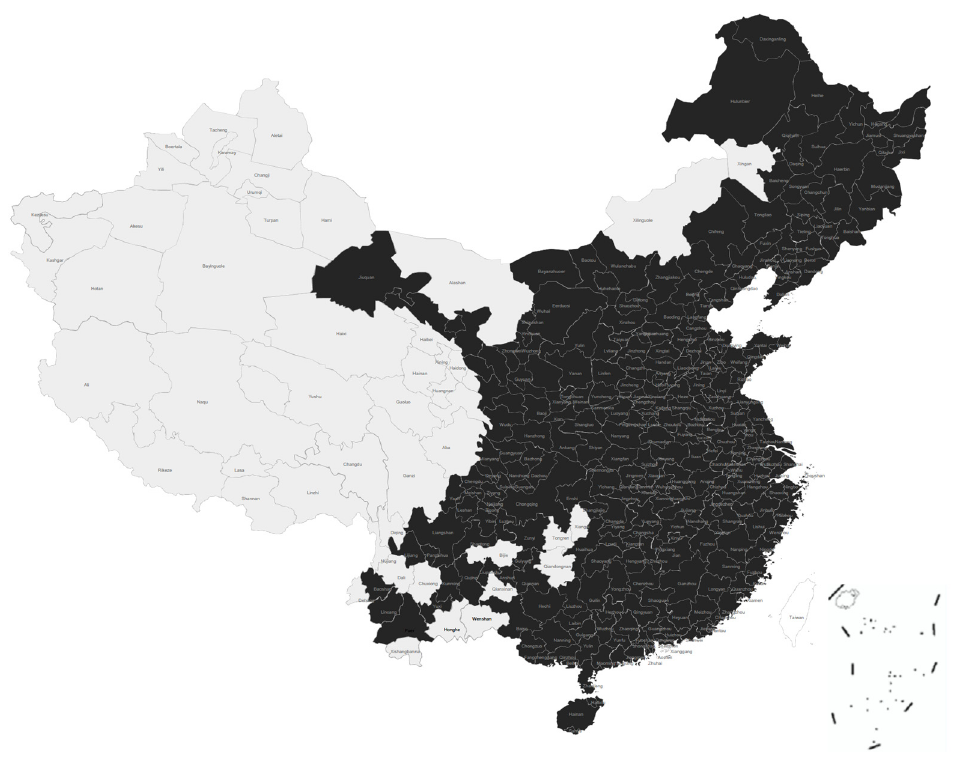
Figure 5. Distribution of the sampled municipalities. Note: Darkly shaded regions correspond to municipalities used in our analysis.